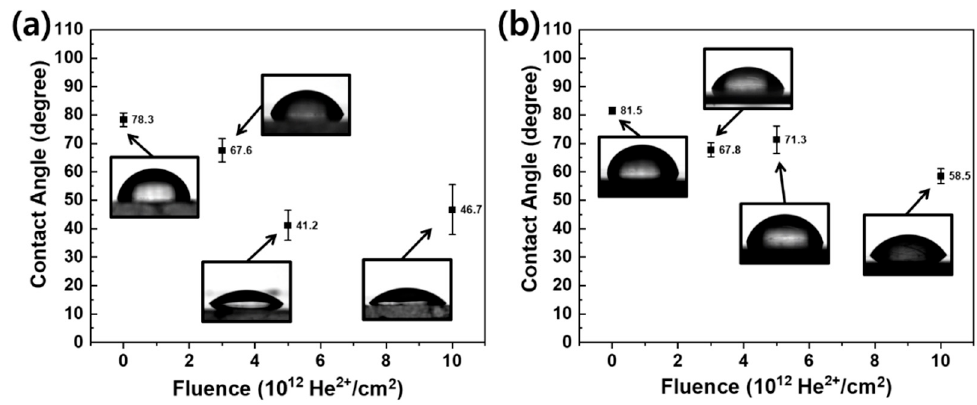
Figure 1. Water CA plots of ( a ) PS and ( b ) HDPE irradiated at various fluences.